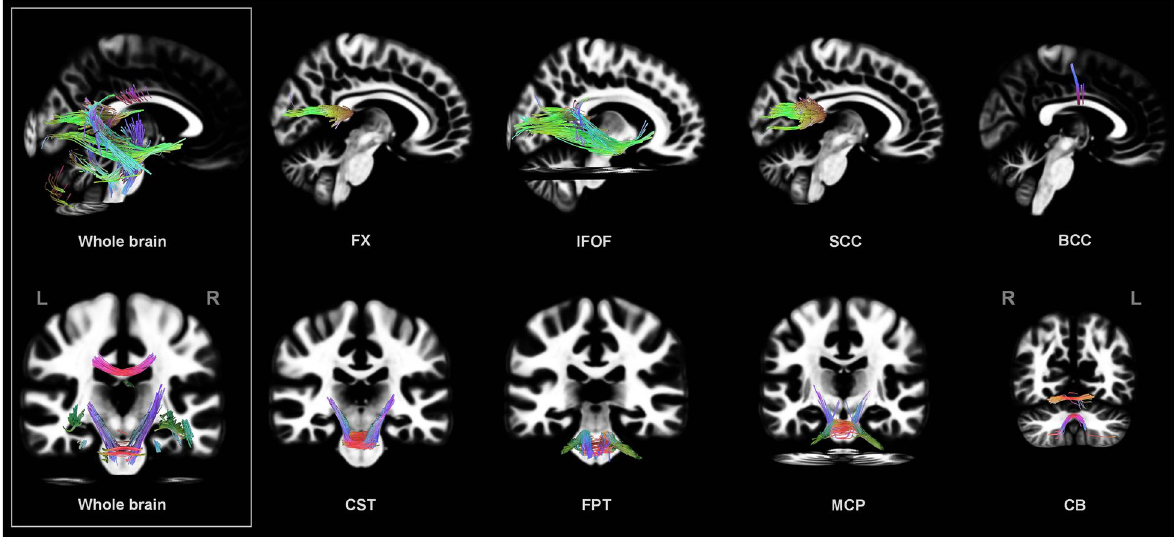
Fig. 4 Three‑dimension tractography showing the signal enhancement area using high‑dielectric pad. The different colors represent different directions of the neuronal fibers. FX Fornix; IFOF Inferior fronto‑occipital fasciculus; SCC Splenium of corpus callosum; BCC Body of corpus callosum; CST Corticospinal tract; FPT Frontopontine tract; MCP Middle cerebellar peduncle; CB